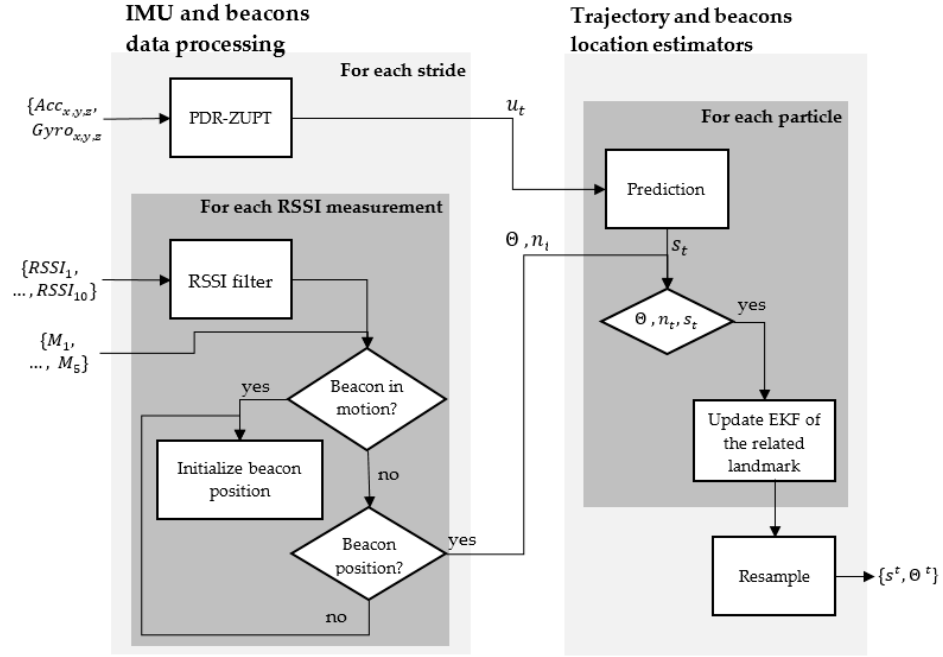
Figure 3. The proposed method for Simultaneous Pedestrian Indoor Localization and house mapping.